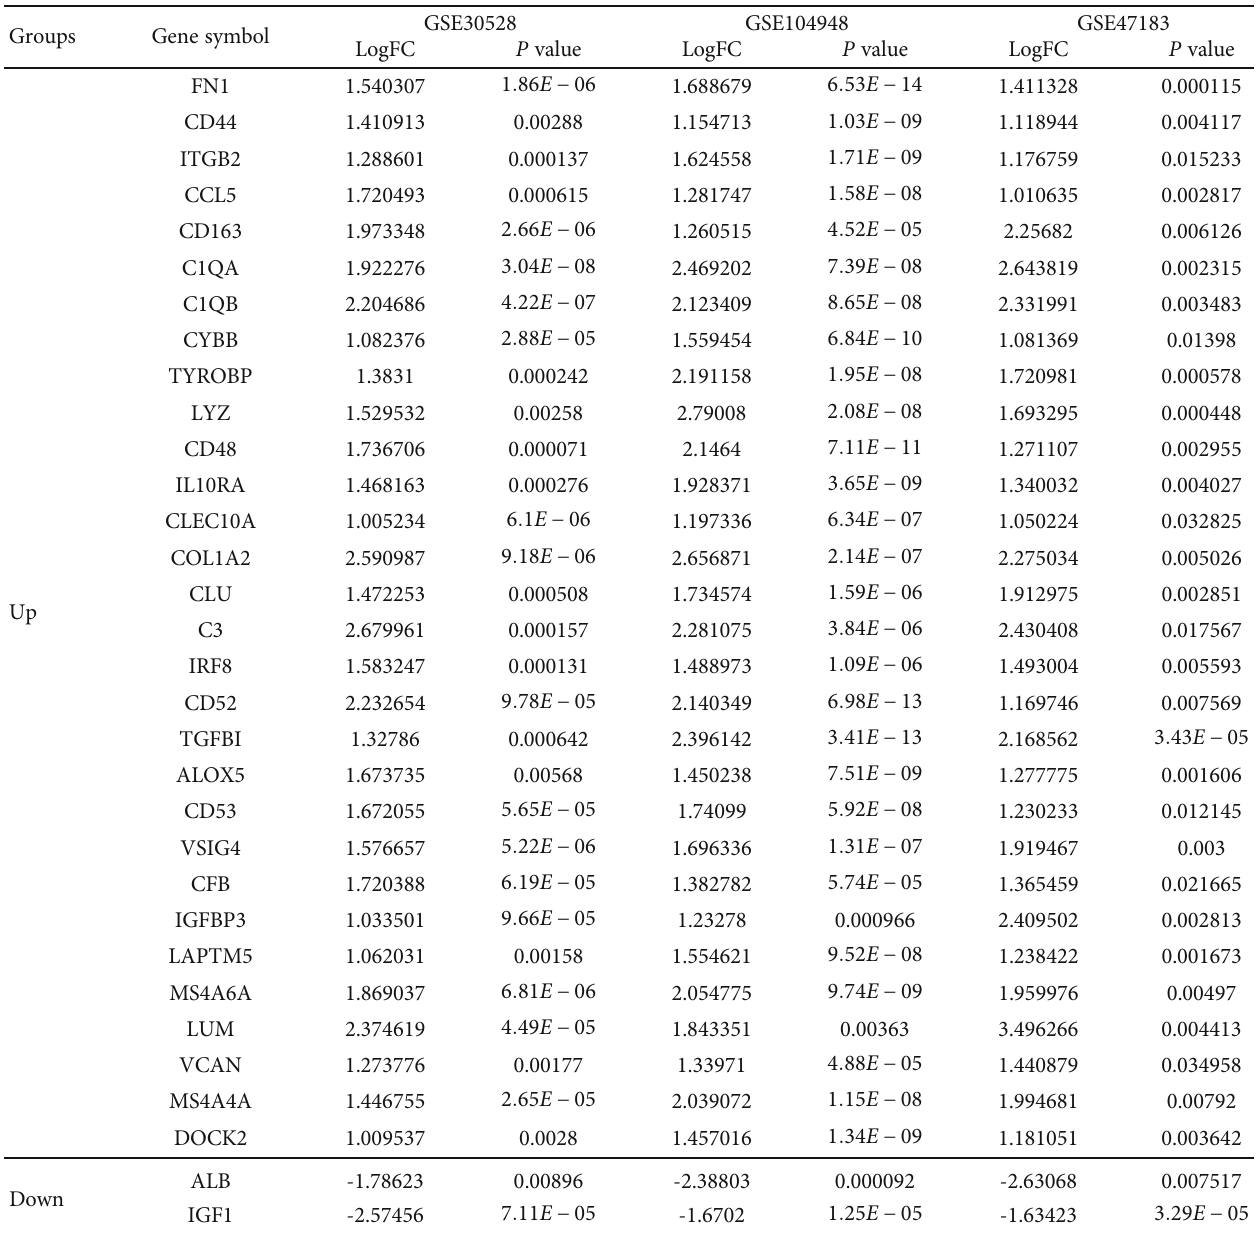
Table 2: Hub genes of diabetic